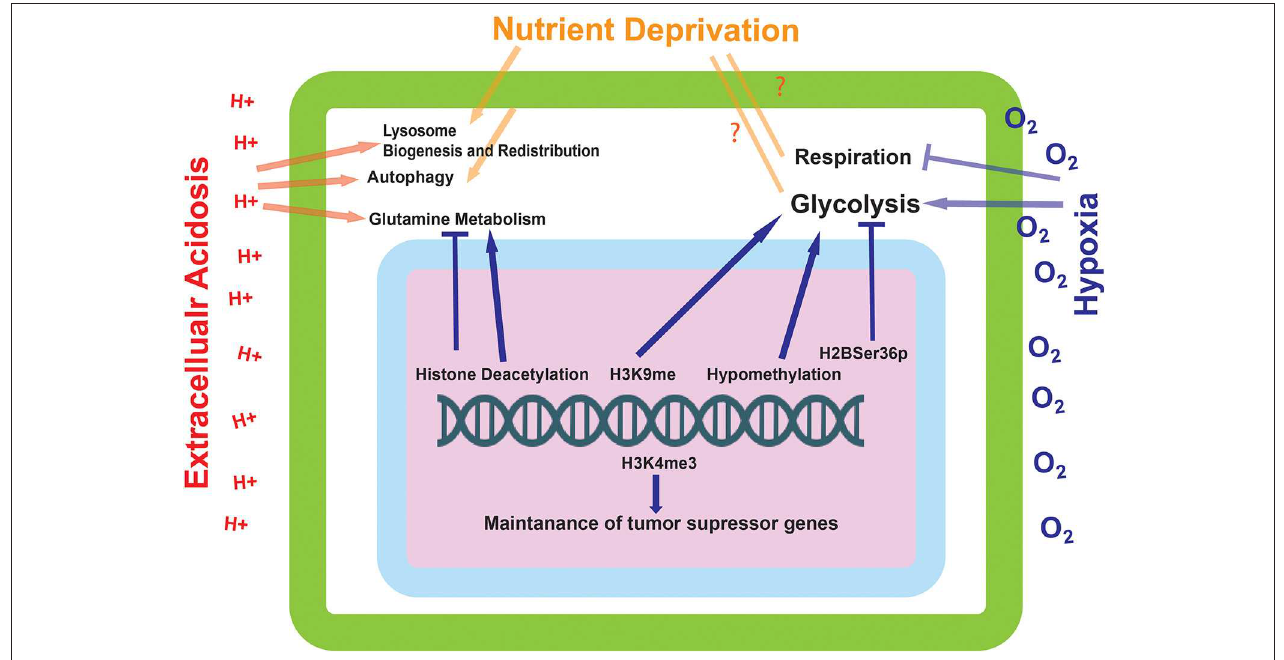
FIGURE 3 | The effect of environmentally induced epigenetic modifications on tumor cell expression and metabolism. The epigenetic modifications made by the proteins influenced by the environmental sensing mechanisms go on to alter the metabolic state of the cell. These modifications can alter the cells ability to metabolize glutamine and carry out glycolysis, as well as influence the transcriptional status of tumor suppressor